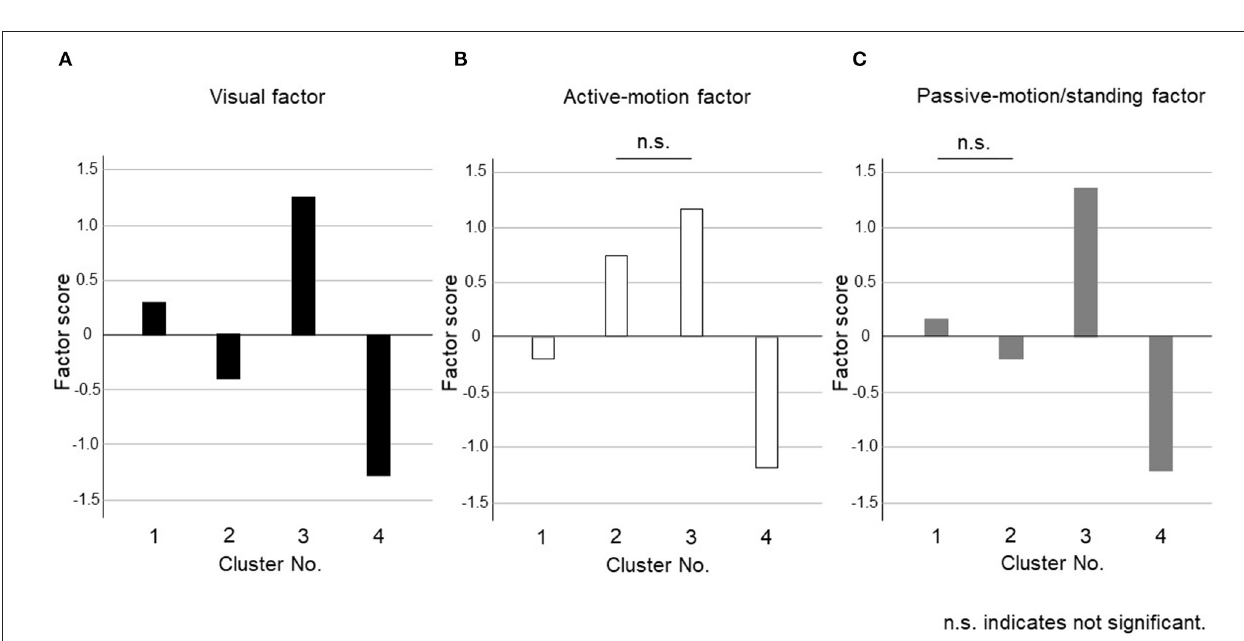
FIGURE 1 | Dendrogram of patients constructed by the Ward clustering method. Four clusters were initially selected by using the factor scores obtained through the previous factor analysis.